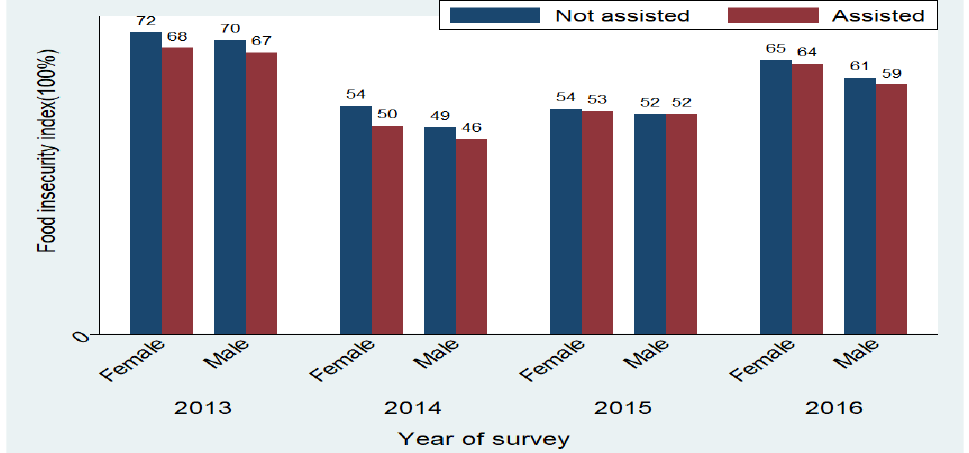
Figure 6. Food insecurity by gender and assistance status of the respondent.